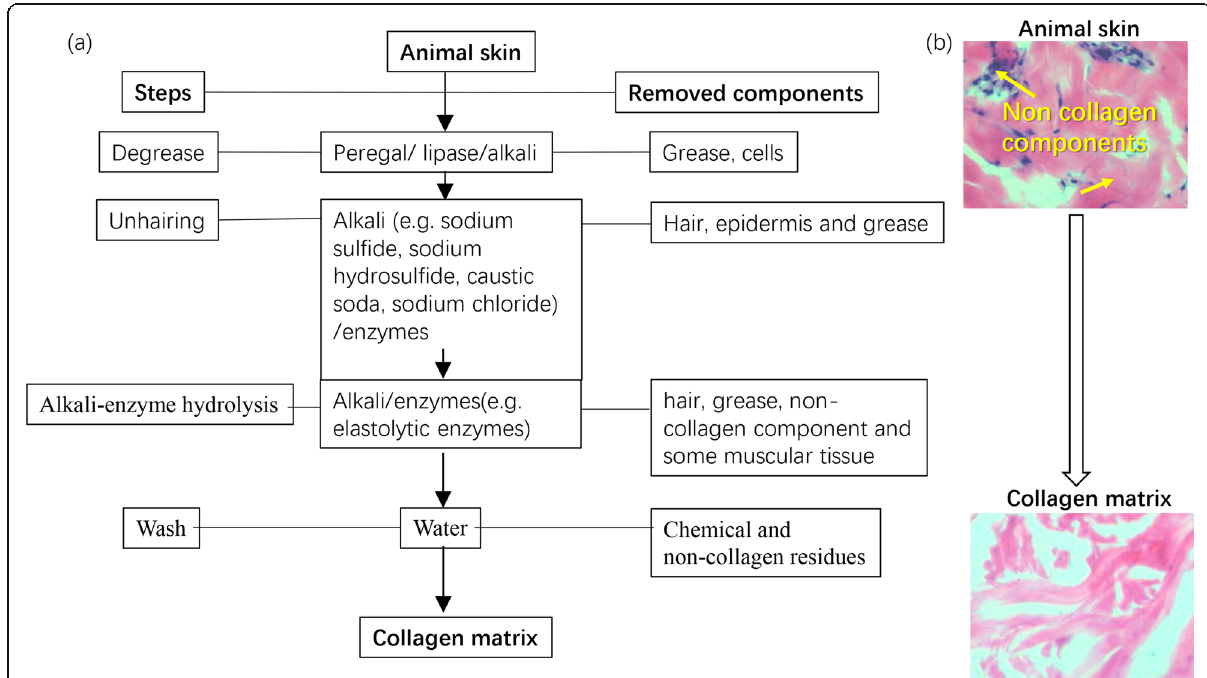
Fig. 1 a Chart of treatment process of animal skin to collagen matrix; b Microscope image showing structural component of skin before and after treatment [10]. Copyright (2016), with permission from